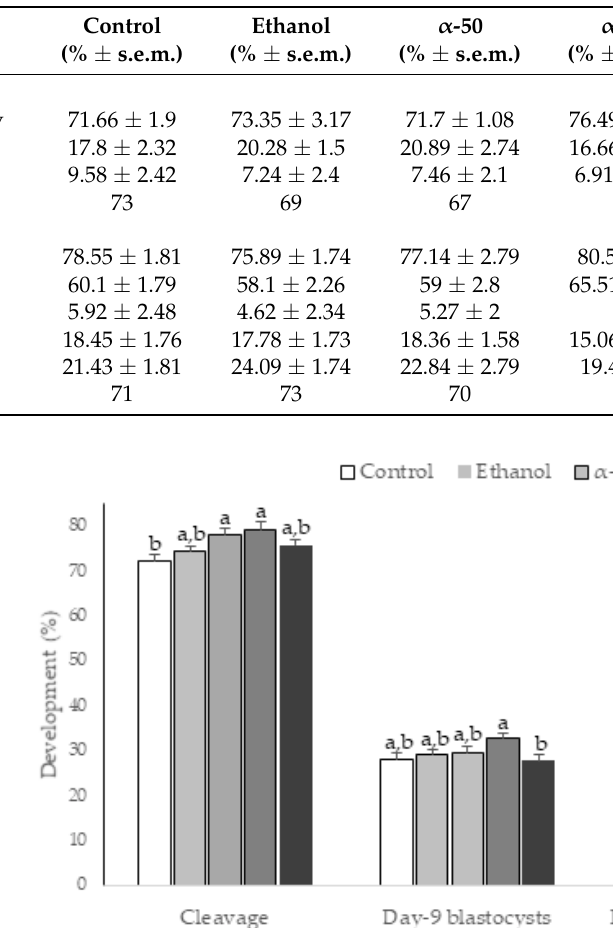
Table 4. Percentages (% ± s.e.m.) of mature (metaphase II, immature and degenerate) and fertilized (total, normal, polyspermic, asynchronous and not fertilized) bovine oocytes collected in summer and in vitro matured in absence (control and 0.05% ethanol) or presence of α -tocopherol at 50 ( α -50), 100 ( α -100) and 200 ( α -200) µ M.